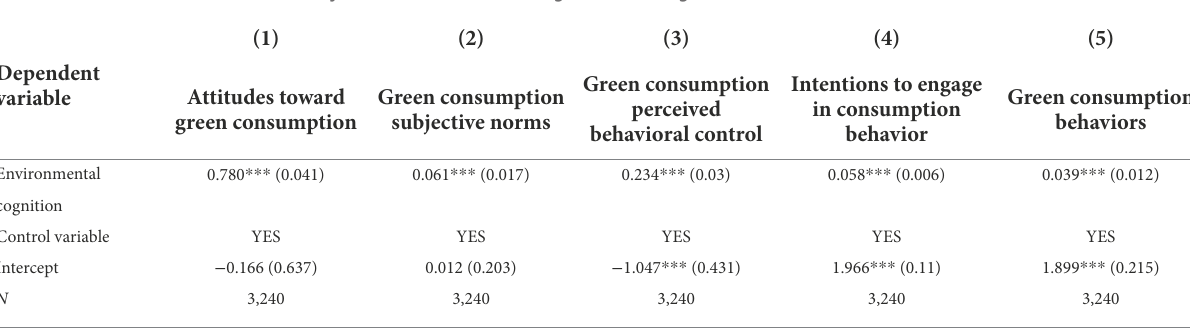
TABLE 7 Estimation results of the multilayer linear model considering the central